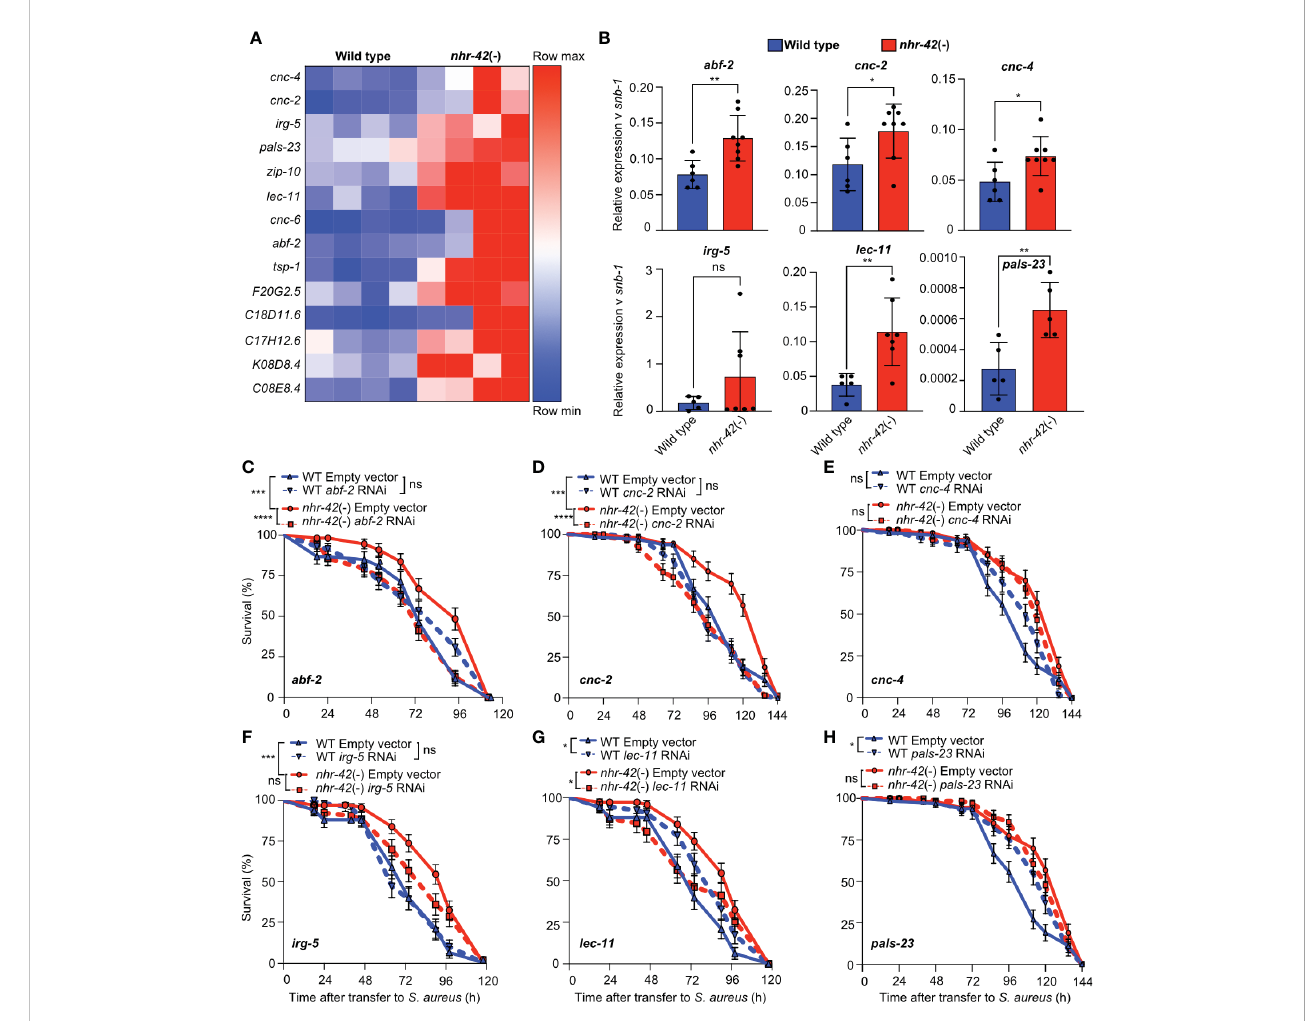
FIGURE 6 Antimicrobial genes required for enhanced infection survival of nhr-42 mutants (A) Host defense genes upregulated in noninfected nhr-42 (tm1375) mutants relative to wild type. Row-normalized FPKM values. (B) RT-qPCR of transcripts for select antimicrobial genes in noninfected wild type and nhr-42 (tm1375) mutants. 5-8 biological replicates. N = ~1,000 animals per replicate. * P ≤ 0.05, ** P ≤ 0.01. ns, not signi fi cant. t -test. (C) Infection survival of wild type and nhr-42 (tm1375) animals fed E. coli HT115 expressing RNAi empty vector or abf-2 dsRNA DNA prior to infection with S. aureus SH1000. Data are representative of 3 independent replicates. (D) Infection survival of wild type and nhr-42 (tm1375) animals fed E. coli HT115 expressing RNAi empty vector or cnc-2 dsRNA prior to infection with S. aureus SH1000. Data are representative of 2 independent replicates. (E) Infection survival of wild type and nhr- 42 (tm1375) animals fed E. coli HT115 expressing RNAi empty vector or irg-5 dsRNA prior to infection with S. aureus SH1000. Data are representative of 2 independent replicates. (F) Infection survival of wild type and nhr-42 (tm1375) animals fed E. coli HT115 expressing RNAi empty vector or pals-23 dsRNA prior to infection with S. aureus SH1000. Data are representative of 2 independent replicates. (G) Infection survival of wild type and nhr-42 (tm1375) animals fed E. coli HT115 expressing RNAi empty vector or cnc-4 dsRNA prior to infection with S. aureus SH1000. Data are representative of 2 independent replicates. (H) Infection survival of wild type and nhr-42 (tm1375) animals fed E. coli HT115 expressing RNAi empty vector or lec-11 dsRNA prior to infection with S. aureus SH1000. Data are representative of 2 independent replicates. * P ≤ 0.05, *** P ≤ 0.001, **** P ≤ 0.0001. ns, not signi fi cant. Log-Rank (Kruskal-Wallis test). The Empty Vector controls for (D, E, H) are the same. The Empty Vector controls for F and G are the same. In (C – H) N = 90-135 animals per